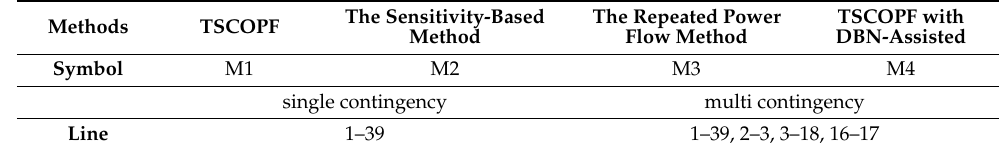
Table 3. Different methods and pre-contingencies for TTC calculation.